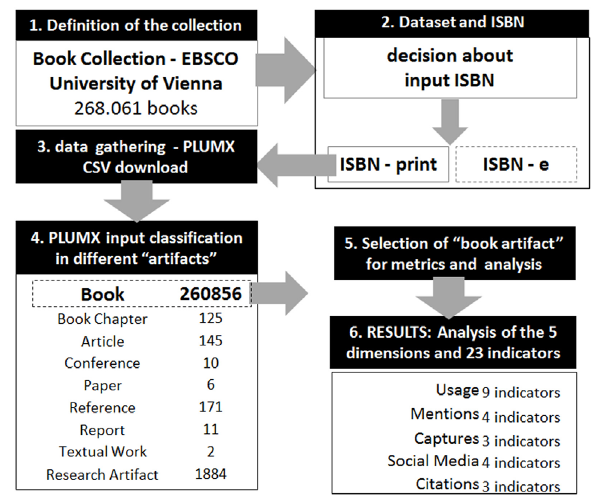
FigUre 2 | General view of the methodology and data gathering process for a collection of books in